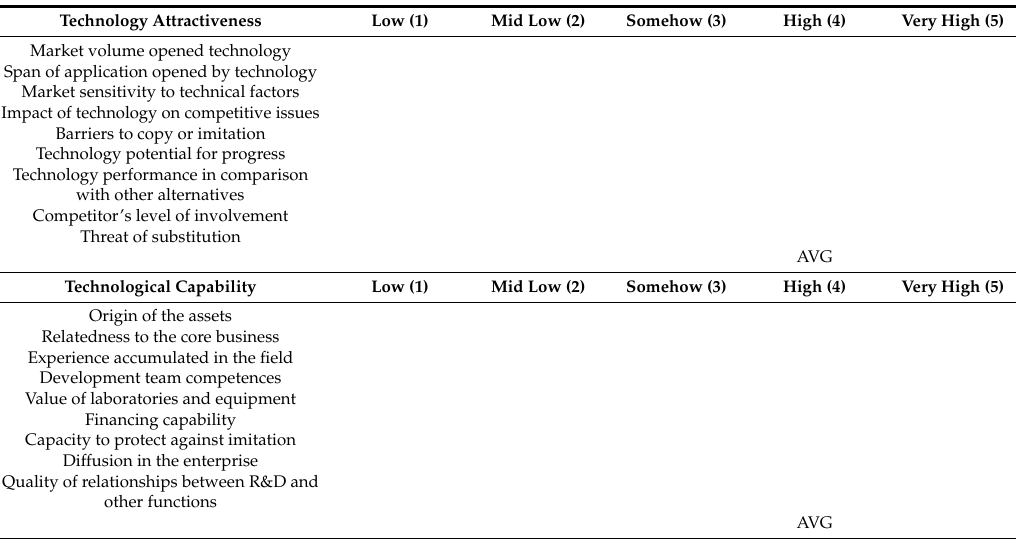
Table A2. Technology Attractiveness and Capabilities